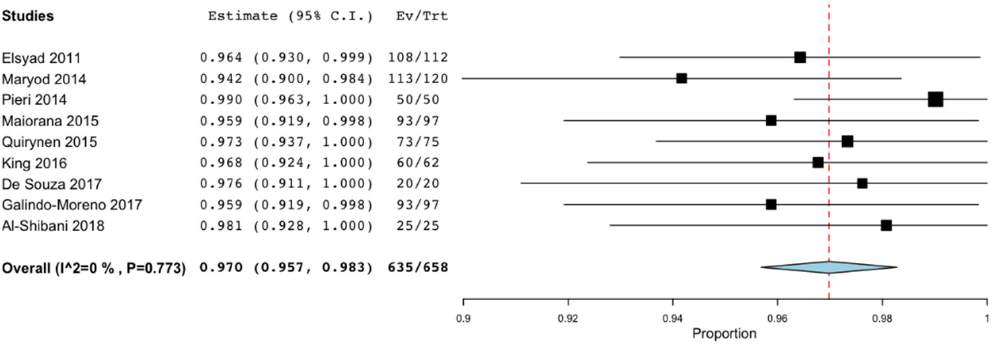
Figure 4. Survival rate at 36 months.